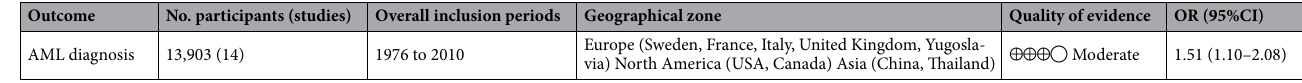
Table 2. GRADE summary of findings